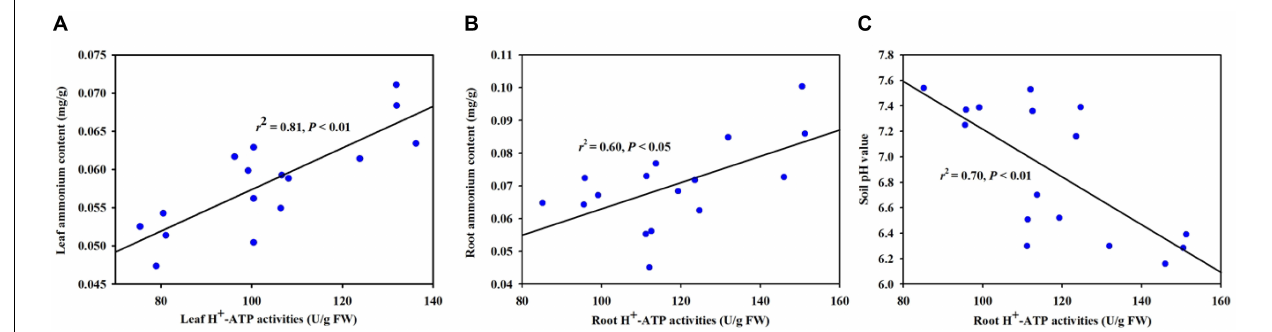
FIGURE 7 | Linear regression between H + -ATPase activity and ammonium content in leaf (A) and root (B) and between root H + -ATPase activity and soil pH value (C) ( n = 16).